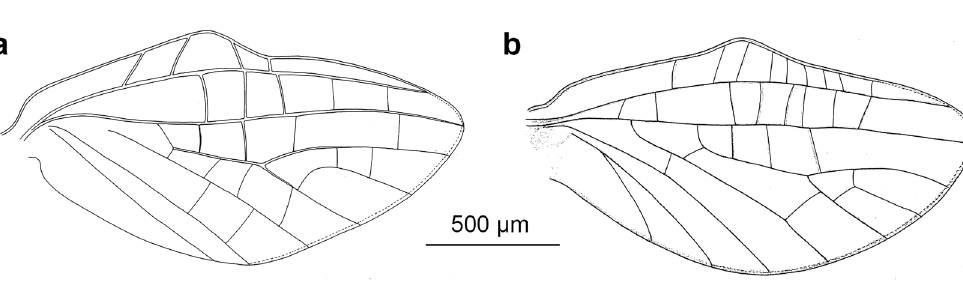
Figure 12. Hind wings of male imagines of ( a ) Calliarcys humilis Eaton, 1881 and ( b ) C. van Godunko & Bauernfeind,